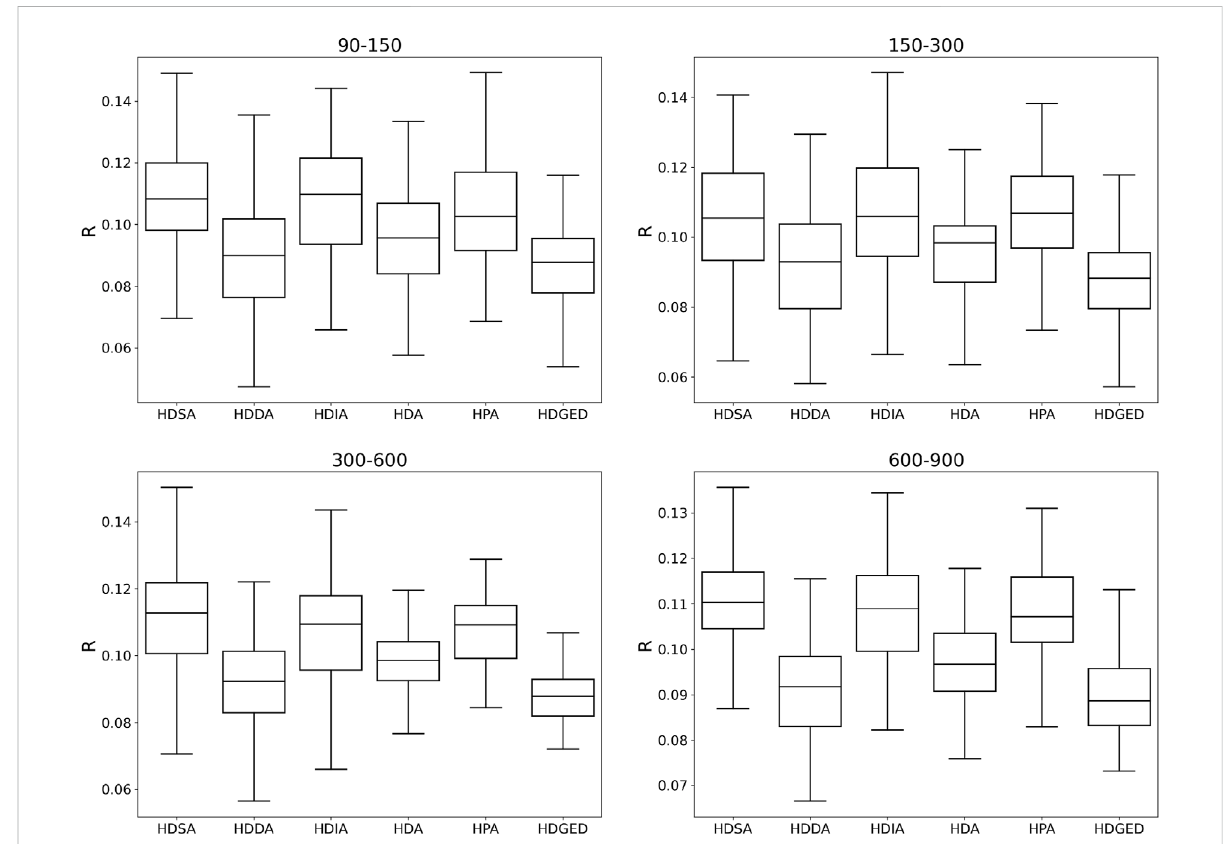
FIGURE 11 Comparison ofdisintegrationcapability ofHDGEDandbaselinealgorithmsonsmallworldHCNoffourdifferentscaleswithoutconsidering the cost of network